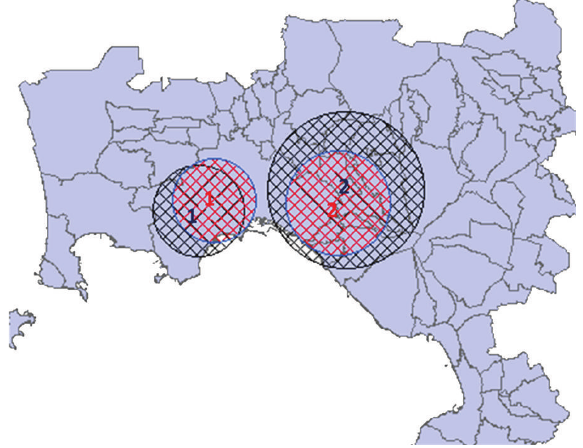
Figure 9: Nasal polyposis disease—years 2011 and 2012: display of the two hotspots’ series.